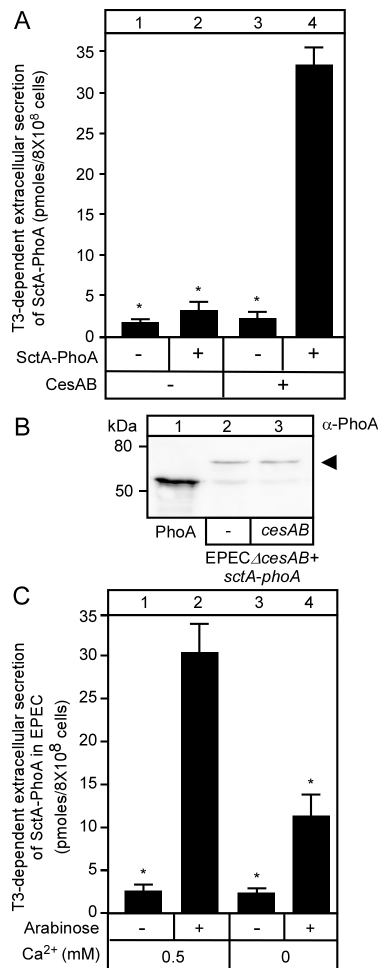
Figure 3. T3S-dependent secretion of SctA-PhoA and native SctA have the same requirements. ( A ) Quantification of SctA-PhoA secreted in the absence and presence of the CesAB chaperone in EPEC ∆ cesAB carrying pASK-IBA7 + cesAB ; Bar graphs with SEM are shown; n = 3 biological repeats. Unpaired parametric t -test was performed, *: p < 0.01. ( B ) Intracellular production of SctA-PhoA in the absence or presence of CesAB in EPEC ∆ cesAB cells. Polypeptides were analyzed as in Figure 1D, and immuno-stained with α -PhoA. A representative image is shown. Arrow indicates SctA-PhoA; Lane 1: 100 ng of PhoA-His purified as previously described [15]. n = 3 biological repeats. ( C ) Quantification of SctA-PhoA secreted extracellularly by EPEC cells in the presence (0.5 mM CaCl 2 ) and absence (0.1 mM EGTA) of Ca 2+ . Bar graphs with SEM are shown; n = 3 biological repeats. Unpaired parametric t -test was performed, *: p < 0.01.